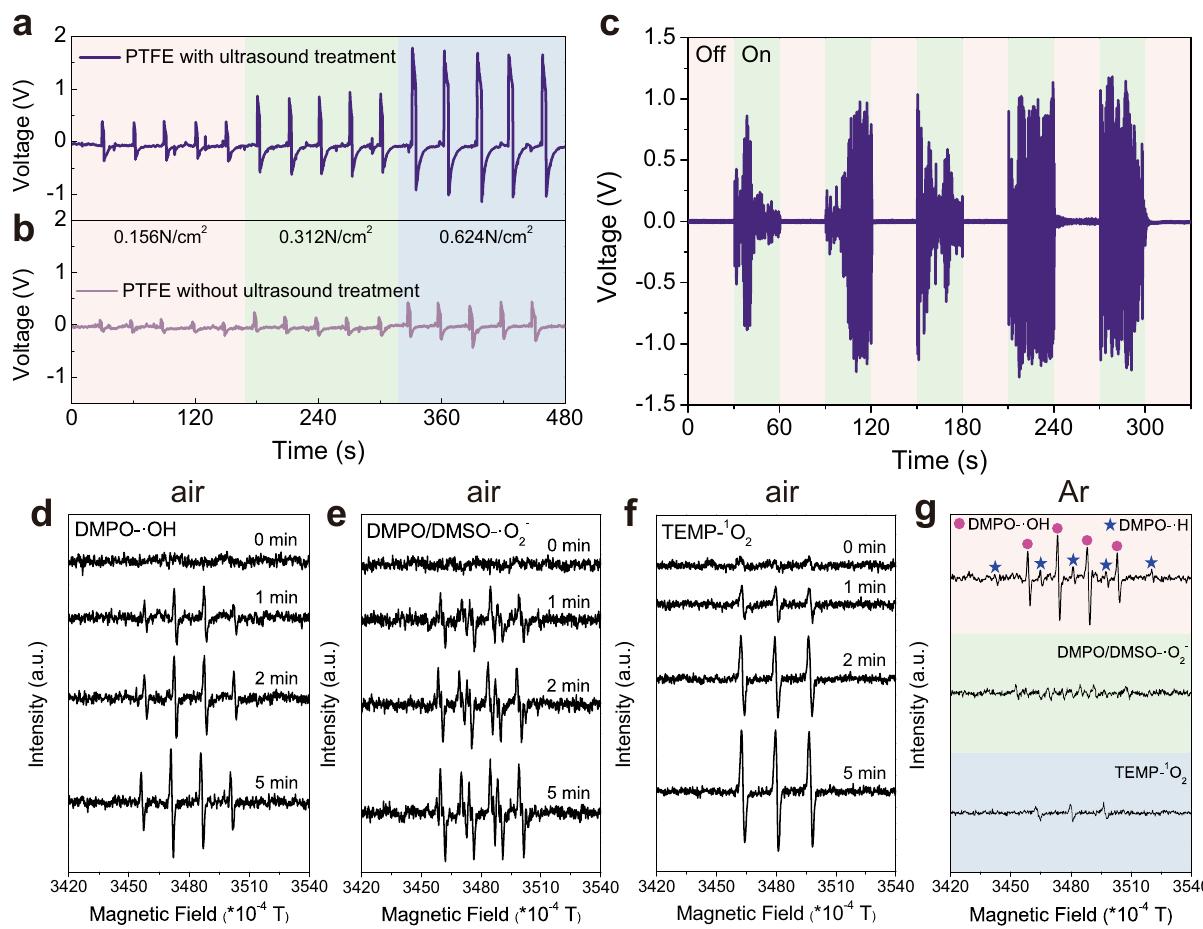
Fig. 3 Piezoelectric properties of the PTFE and ROS generation. a Voltage output of the PTFE membrane activated with ultrasound treatment and b without ultrasound activation under compression by three different pressure forces. c Reproducible voltage output of the PTFE membrane when the ultrasonic cleaner was turned on and off. Schematic illustration of PTFE membrane device see Supplementary Fig. 3. d , e , f Under air and g Ar atmosphere, ESR signals for DMPO- (cid:129) OH, DMPO- (cid:129) H, DMPO/DMSO- (cid:129) O 2 − , TEMP- 1 O 2 over PTFE powders under ultrasound